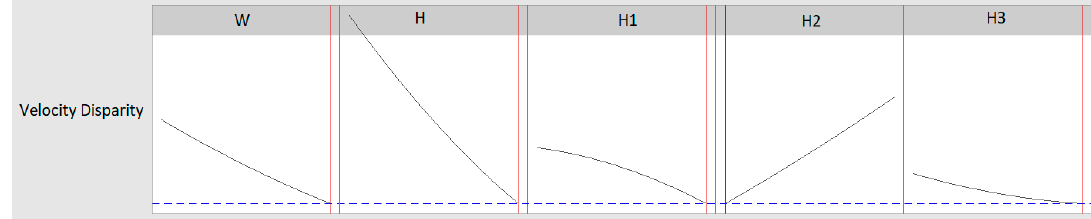
Figure 6. Main effects plots for velocity disparity. Figure 6. Main e ff ects plots for velocity